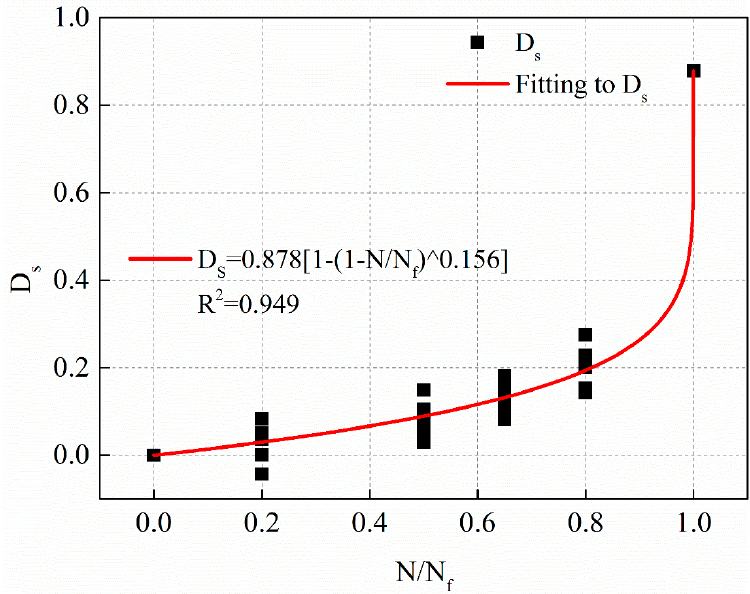
Figure 19. The fatigue damage evolution curve based on residual strength decay with stress levels of 0.5 MPa.